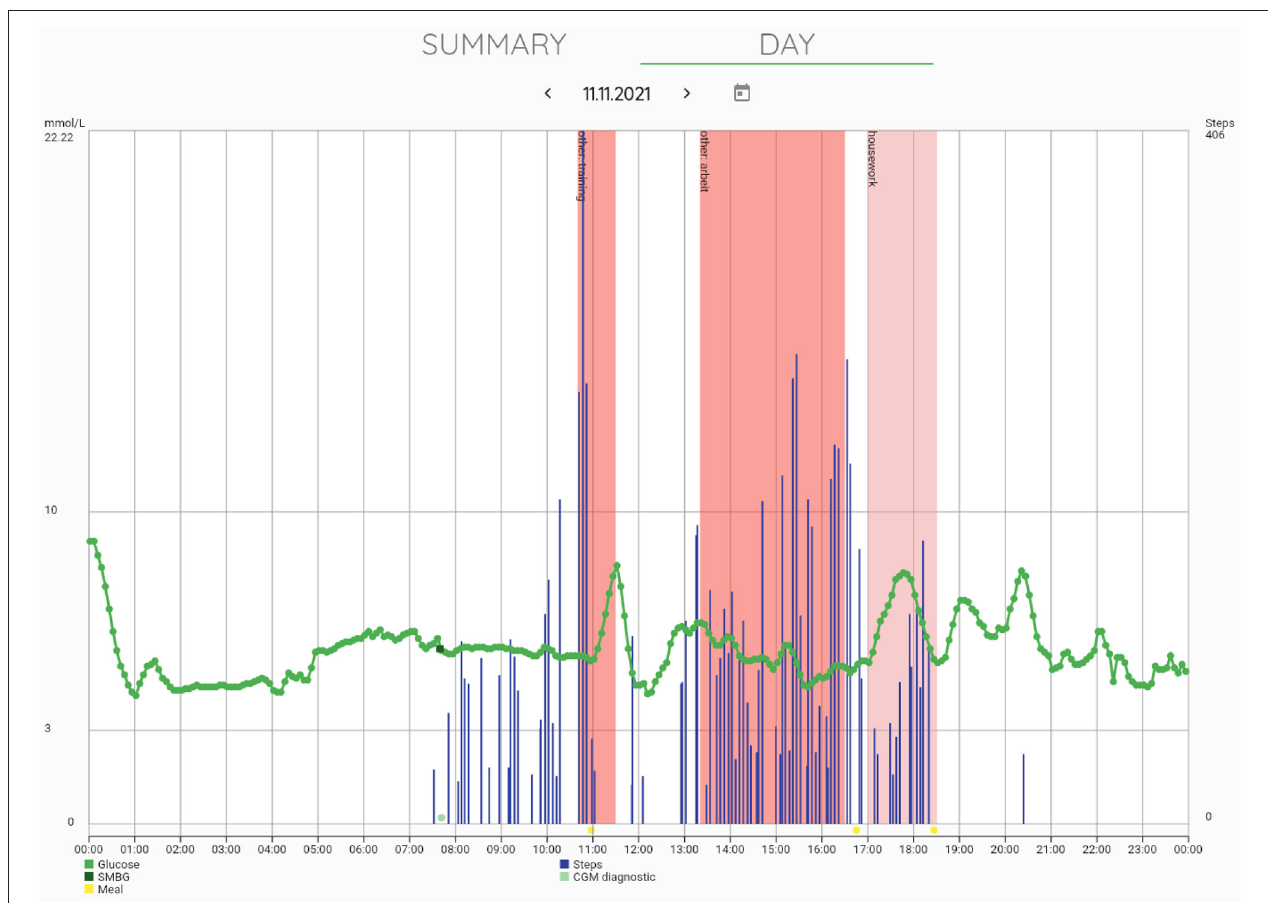
FIGURE 7 | Browser dashboard daily view. The browser dashboard further allows for day-by-day review of glucose trajectories that are displayed in combination with other types of data collected such as self-measured blood glucose (SMBG), step counts from activity trackers, and physical activity logs and meal logs entered by the